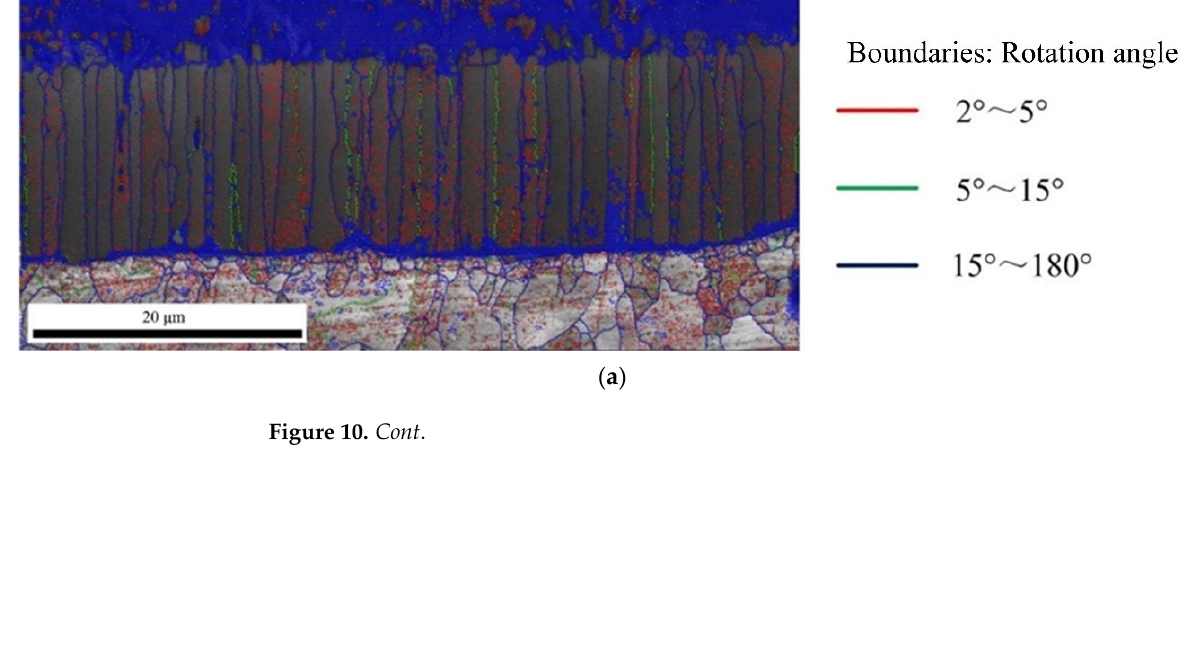
Figure 9. EBSD image of Fe 4 Al 13 phase: ( a ) inverse pole figure map and ( b ) crystal orientation.